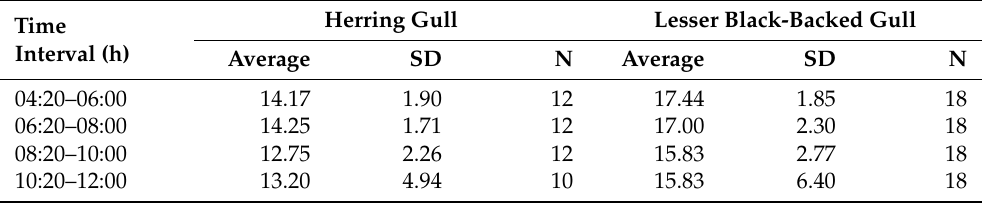
Table 2. Mean number of individuals of HG and LBBG present in two sections of the colony within 2 h periods from 04:20 to 06:00 h. ‘N’ is the number of 20 min intervals where a photo was taken during the 2 (HG) or 3 (LBBG) days of survey.